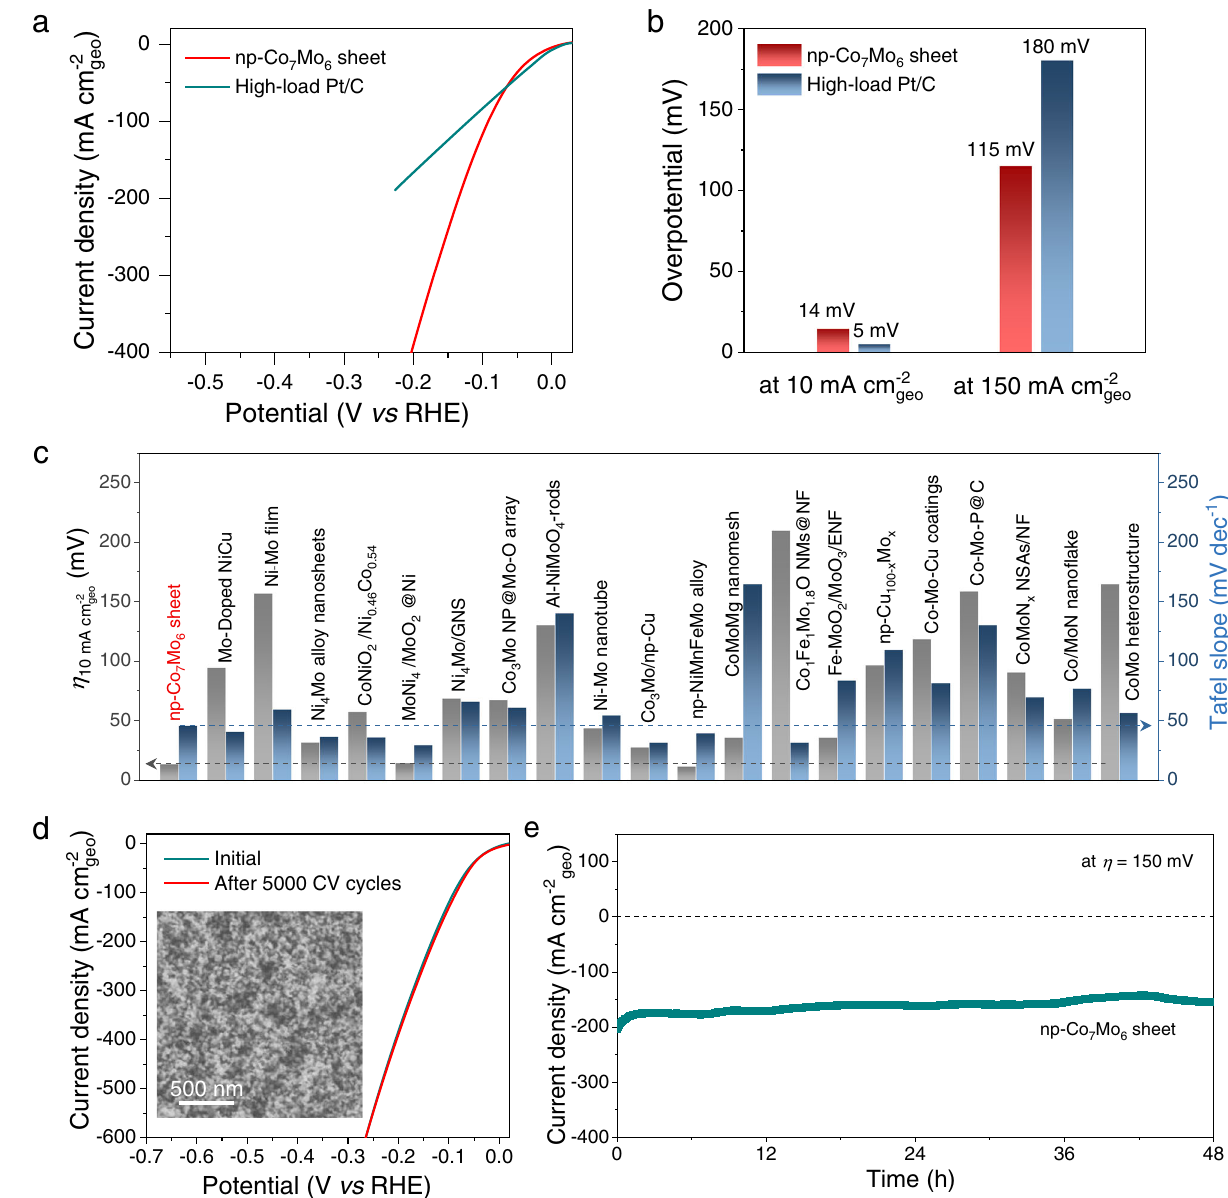
Fig. 6 | HER catalytic performance and durability of the self-supported np- Co 7 Mo 6 sheet electrocatalysts (fabricated at 973K). a iR-corrected HER polar- ization curve as compared to a high-load Pt/C catalyst. b Comparisons of over- potential at 10 and 150mAcm − 2 geo current density. c Overpotential at 10mAcm − 2 geo and Tafel slope of the np-Co 7 Mo 6 sheet in comparison with other Mo-based